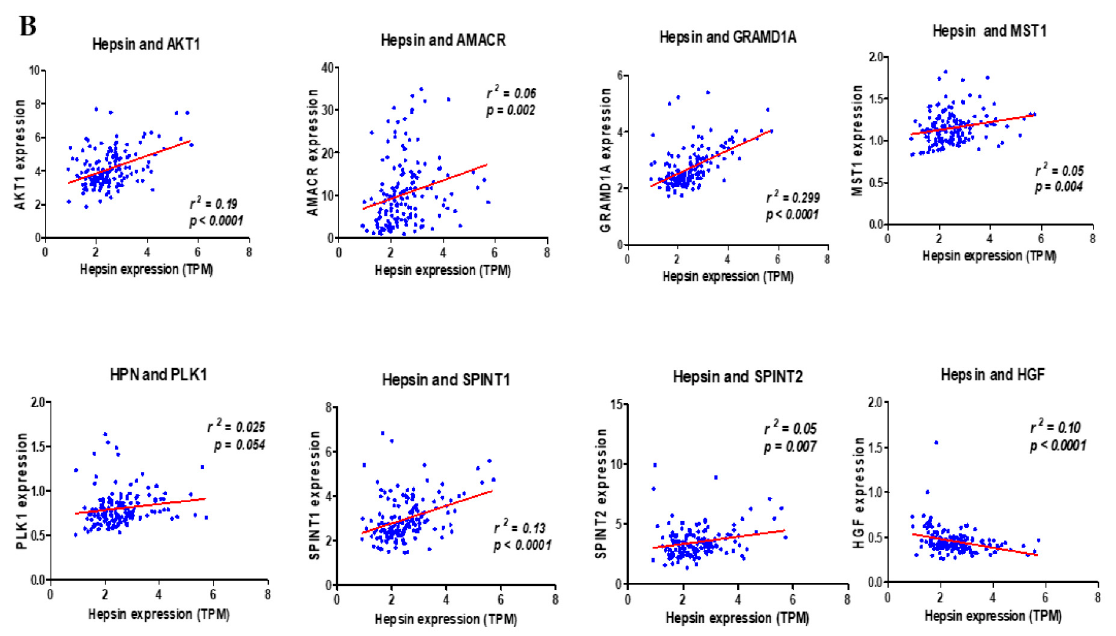
Figure 6. Hepsin PPI network genes’ expression levels and their correlation in prostate cancer. ( A ) Gene expression levels from TCGA data (497 cases of prostate cancer and 52 normal prostate tissues). ( B ) Gene correlation in prostate cancers from Taylor’s 155 cases of prostate